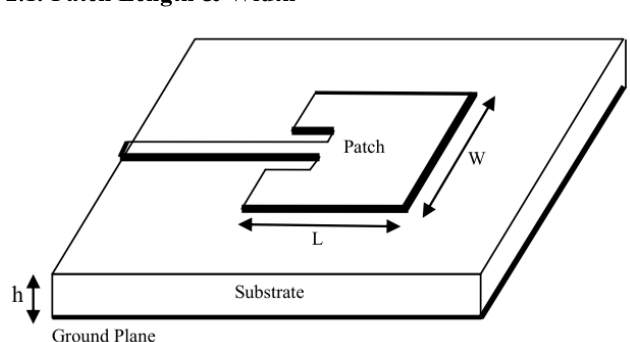
Fig. 1. Microstrip patch antenna [22].